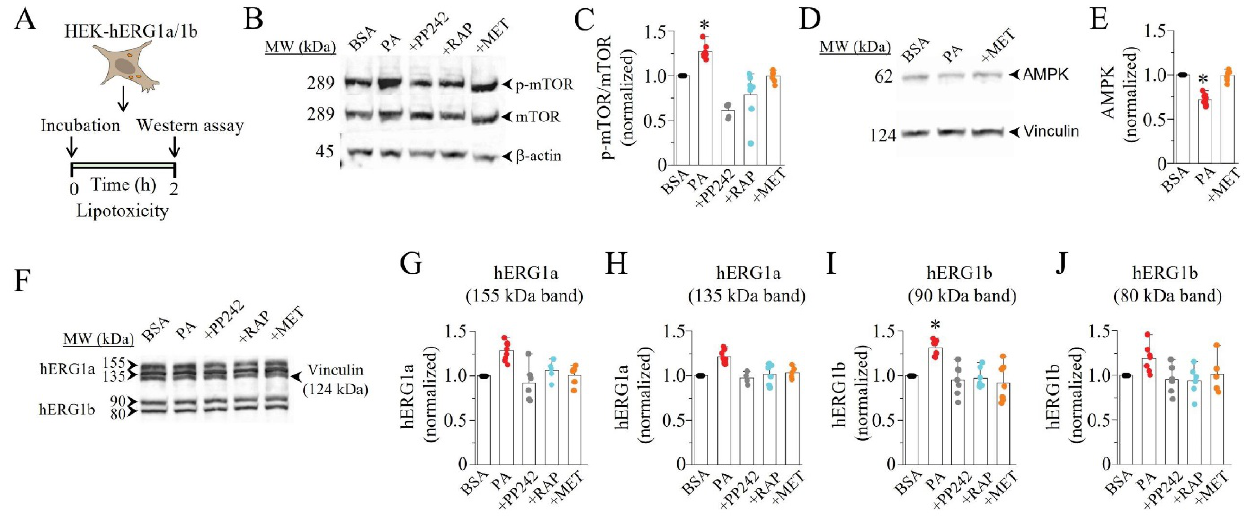
Figure 3. Western blot assay revealed modulation of mTOR, AMPK, and hERG1a/1b expression in lipotoxic HEK293 cells. ( A ) Experimental protocol: mTOR, AMPK, and hERG1a/1b expression in HEK293 cells under control conditions and after pre-exposure to lipotoxicity for 2 h was measured. ( B ) Western blot assays show the levels of activated mTOR (p-mTOR) induced by lipotoxicity in the absence or presence of mTOR inhibitors (PP242 and RAP), or AMPK activator (MET), compared to in control cells. ( C ) Quantification of the Western blot and statistical analysis showing the effects of PP242, RAP, and MET on the levels of p-mTOR. ( D , E ) Western blot and quantification/statistical analysis of AMPK expression in control and lipotoxic cells in the presence or absence of MET. ( F – J ) Western blot and quantification/statistical analysis showing the levels of hERG1a and 1b expression in the absence and presence of PP242, RAP, and MET in control and lipotoxic cells. (* statistical significance at p < 0.05).